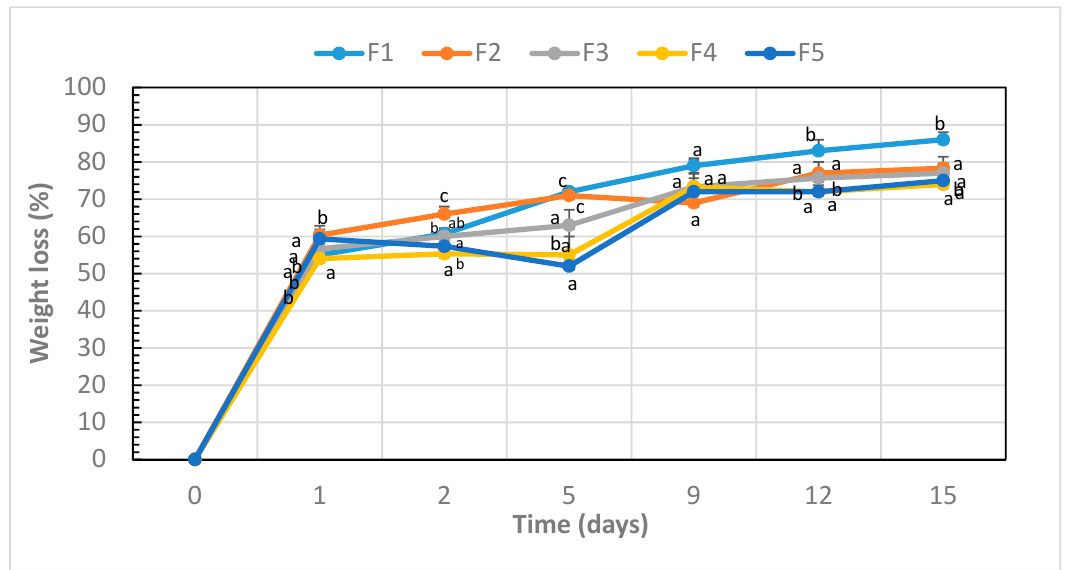
Figure 5. Weight loss vs. time of immersion for the films. Formulations: F1 (CS:PVA:ox-CNO 30:70:0); F2 (CS:PVA:ox-CNO 29.75:70:0.25); F3 (CS:PVA:ox-CNO 29.50:70:0.50); F4 (CS:PVA:ox-CNO 29.25:70:0.75); F5 (CS:PVA:ox-CNO 29.00:70:1.00). Different superscript letters indicate significant differences between treatments ( p > 0.05).